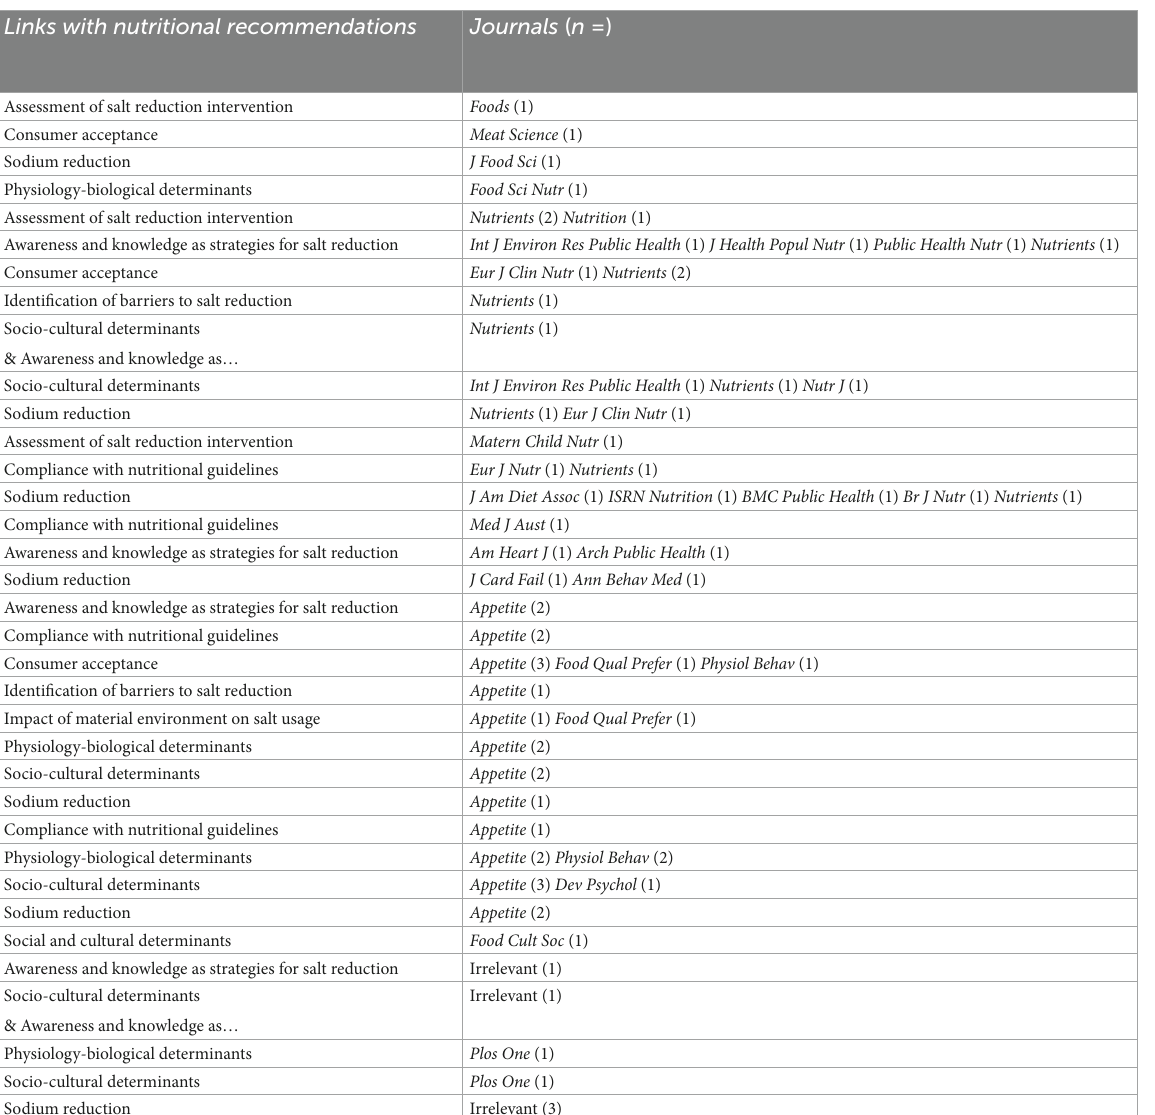
TABLE 2 Salt consumption/health articulation in the thematic category [1] “Socio-demographic and cultural descriptors of salt